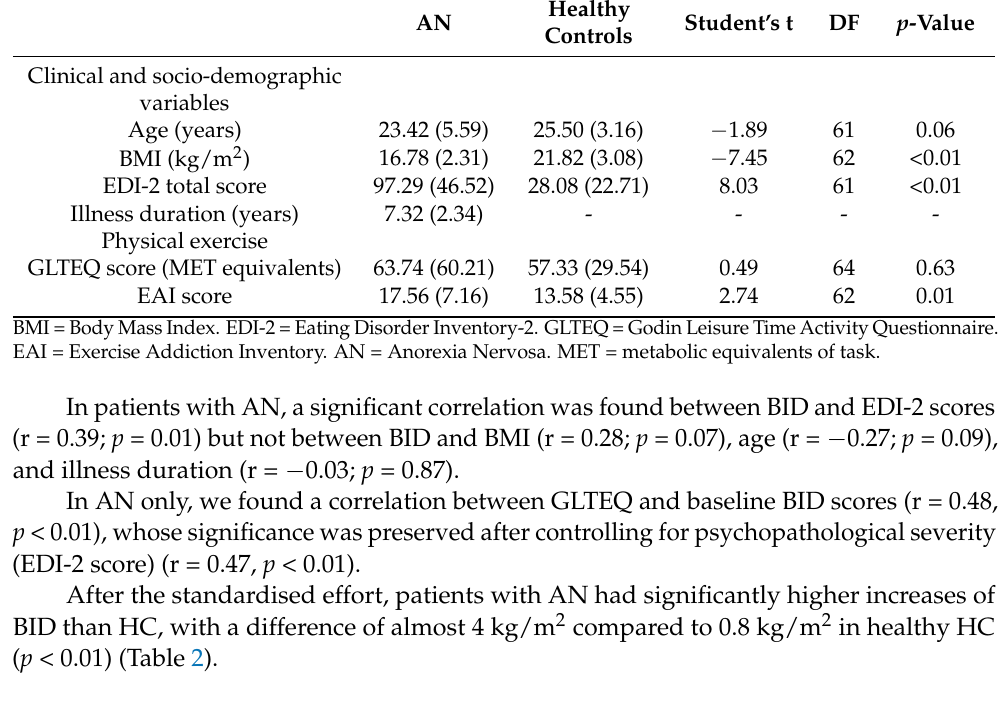
Table 2. Body image distortion at baseline and after a physical effort in patients with anorexia nervosa and healthy controls. Standard deviations are reported in brackets.